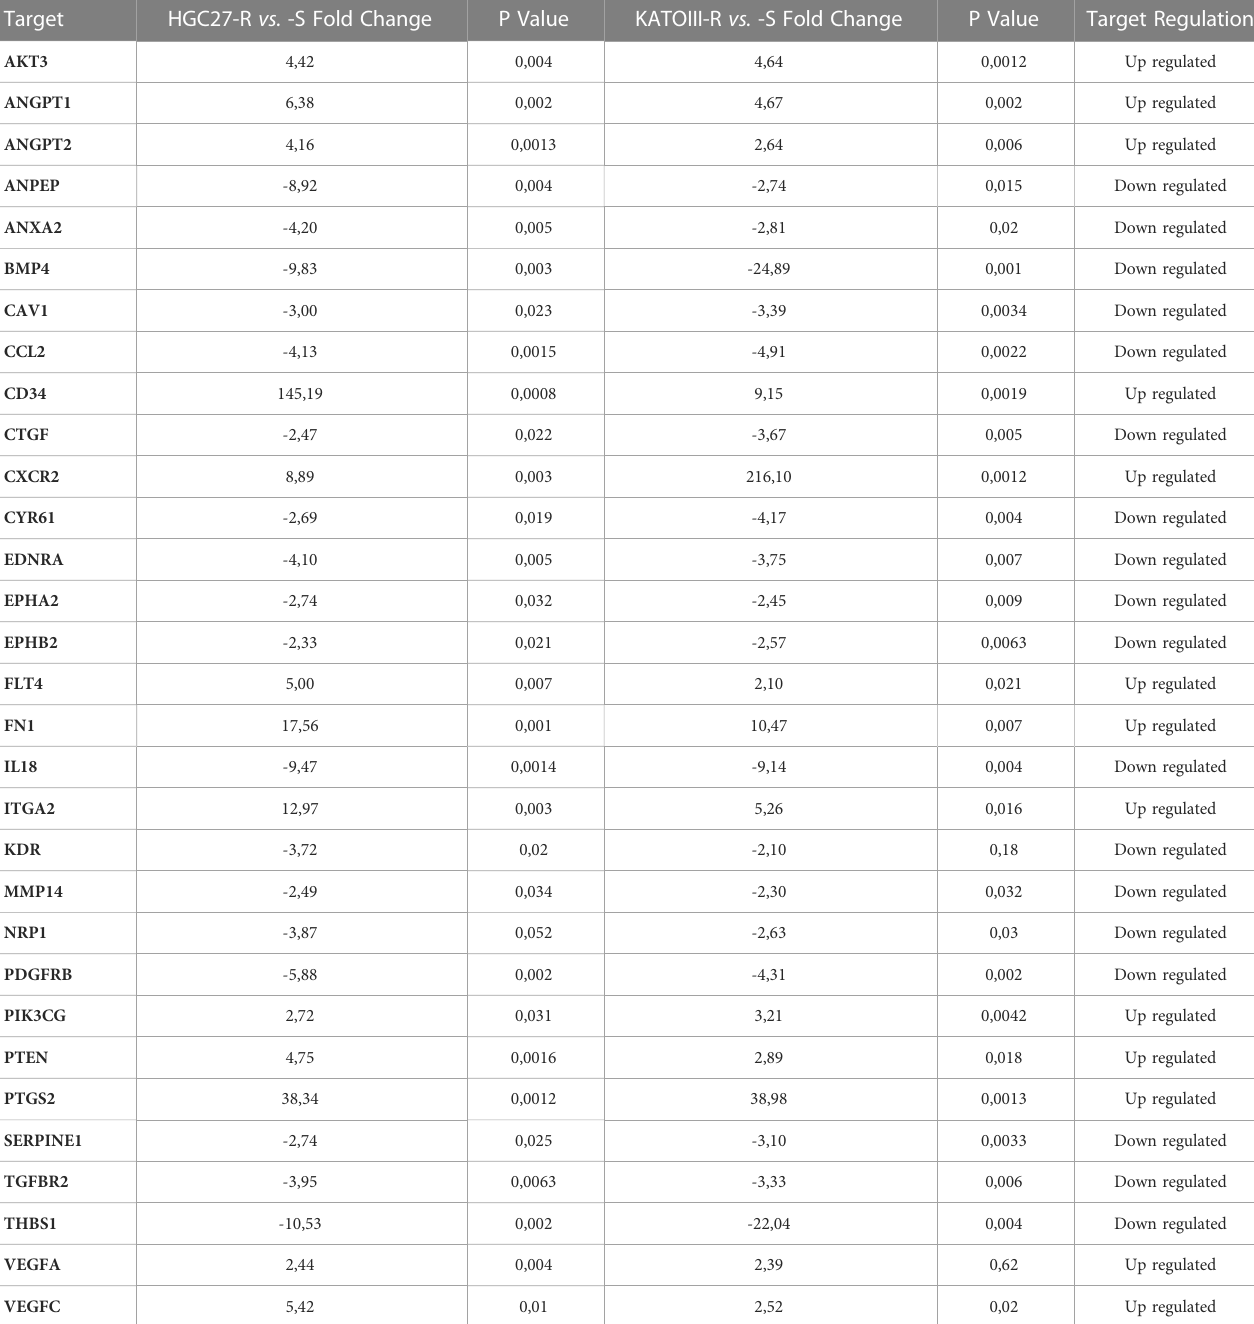
TABLE 1 Thirty-one deregulated genes in PTX-resistant cells (HGC27-R and KATOIII-R) compared to PTX-sensitive ones (HGC27-S and KATOIII-S) were shown. Target HGC27-R vs. -S Fold Change P Value KATOIII-R vs. -S Fold